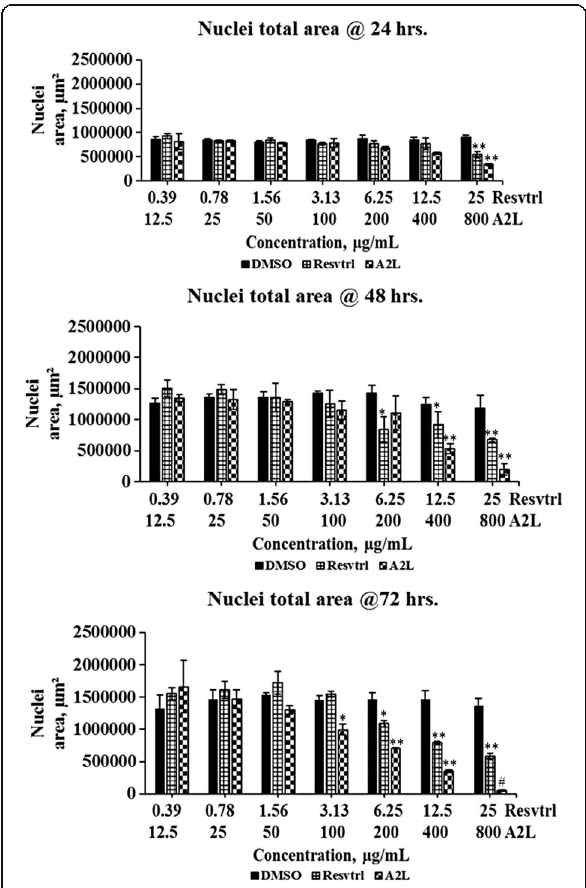
Fig. 3 Determination of nuclei total area. Changes in total nuclear size associated with treatment of HepG2 cells with resveratrol or A2L followed up for three days. * p < 0.05; ** p < 0.01; # p < 0.001